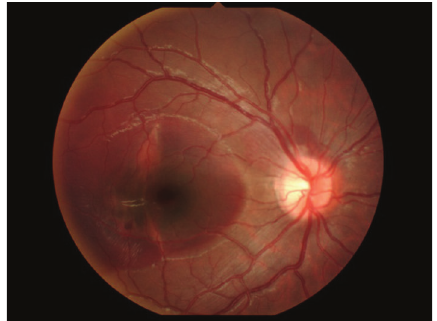
Figure 1: Fundus image showing hemorrhage in the fovea.